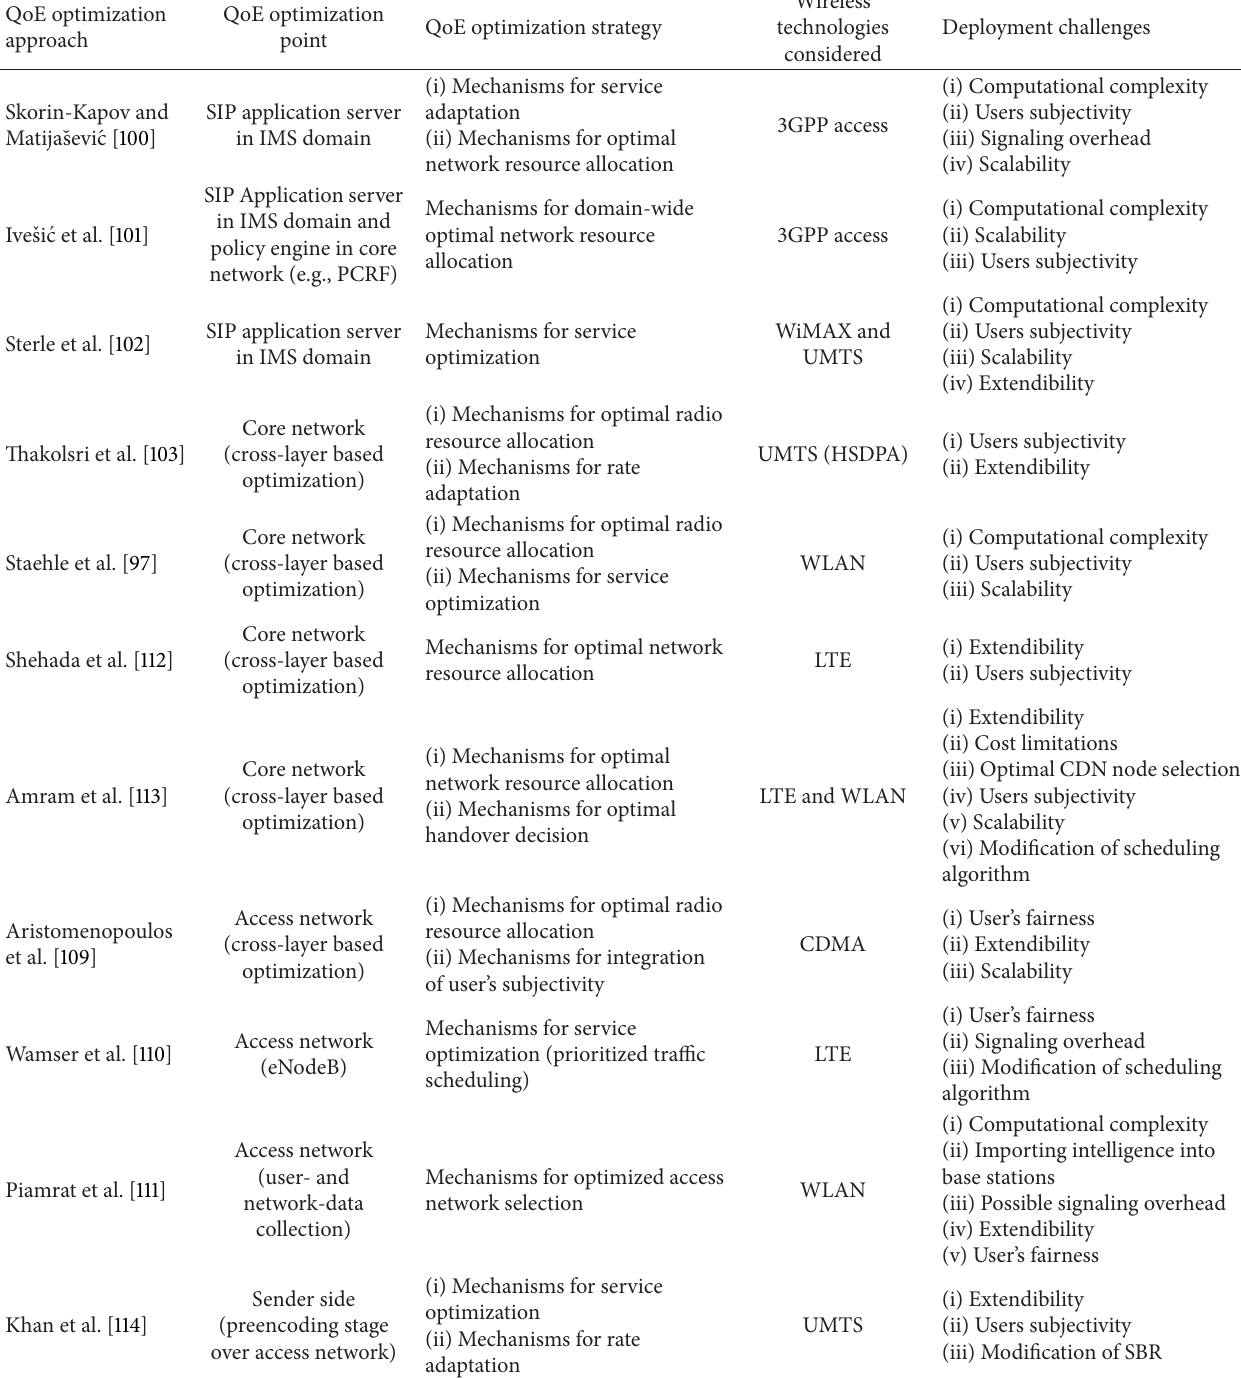
Table 4: An overview of QoE optimization approaches in wireless